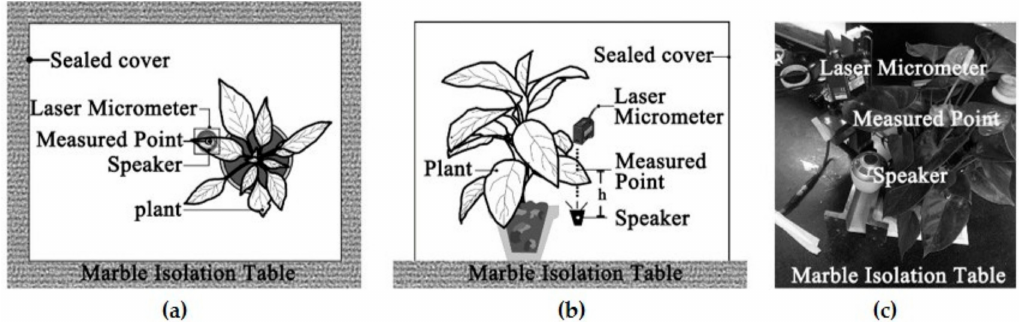
Figure 1. Experimental Setup: ( a ) Overhead view of the measurement; ( b ) Lateral view of the measurement; ( c ) Photograph of the layout.